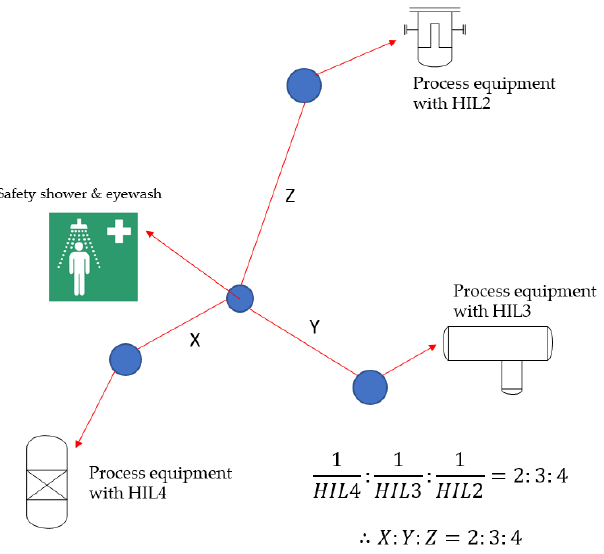
Figure 2. Application for other example of efficient placement of safety shower and eyewash.